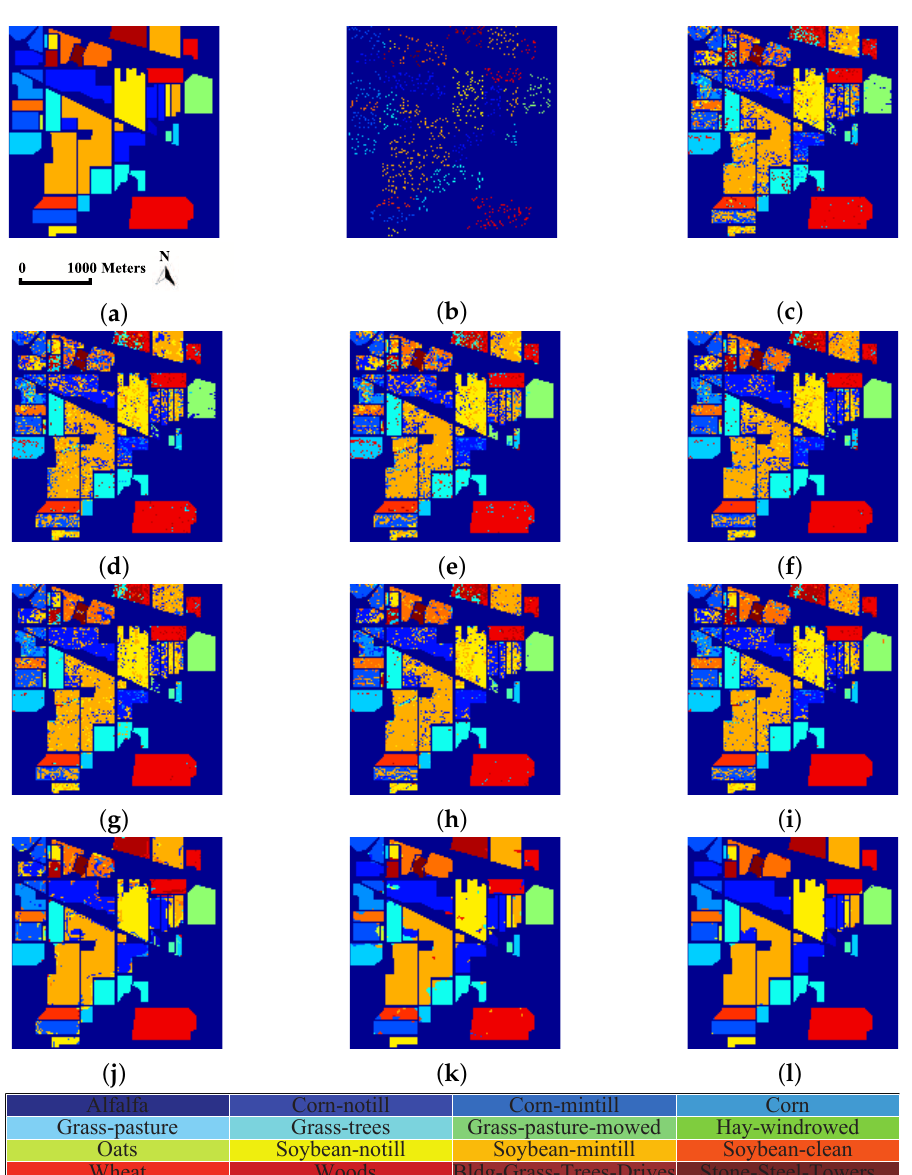
Figure 5. Classification maps of different methods for the Indian Pines dataset: ( a ) ground truth; ( b ) training set; ( c ) origin; ( d ) PCA; ( e ) LDA; ( f ) LFDA; ( g ) SGDA; ( h ) GDA-SS; ( i ) SLGDA; ( j ) MPCA; ( k ) G-LTDA; and ( l )